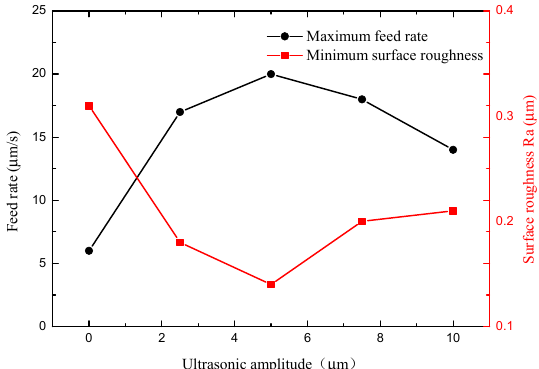
Figure9. Variationinmaximumfeedrateandminimumsurfaceroughness R awithultrasonicamplitude. Chemosensors 2020 , 8 , x Figure 9. Variation in maximum feed rate and minimum surface roughness R a with ultrasonic amplitude.